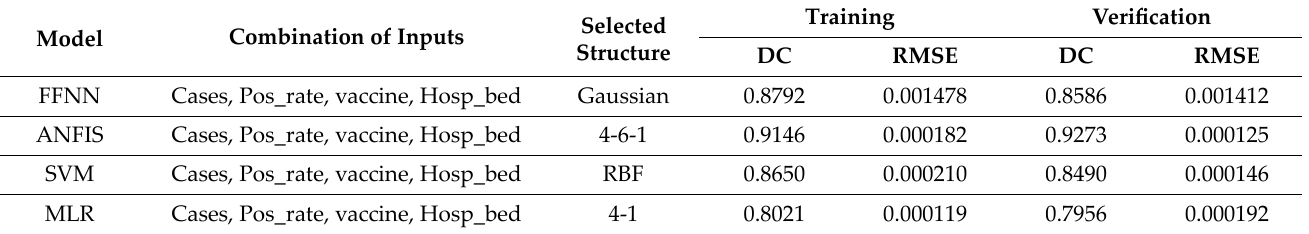
Table 4. Single black‑box models for the modelling of COVID‑19 using the best input